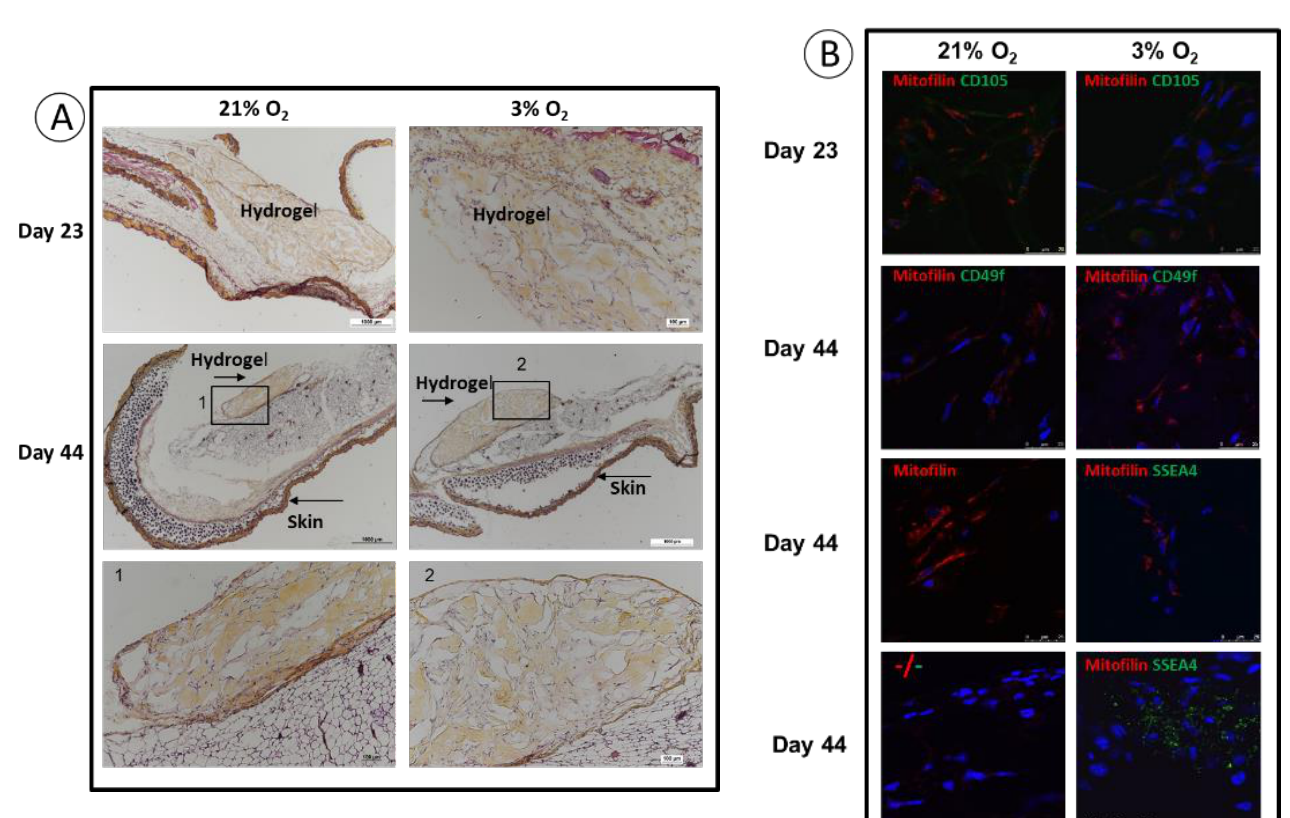
Figure 7. Representative pictures of HES and immunolabelling of sections of grafts recovered at day 23 or day 44. Representative sections of grafts in mice that received SCAPs-Luc+ amplified at 21% or 3% O 2 and seeded in the hydrogel. ( A ) HES staining, with enlargement of hydrogel parts as indicated. ( B ) Immunolabelling with the indicated antibodies. Nuclei are stained with DAPI. The anti-SSEA4 antibody which recognizes the human and mouse cell surface antigen was not expressed along with mitofilin, but was detected in mouse tissue as indicated. Scale bar is 25 µm for panel B.